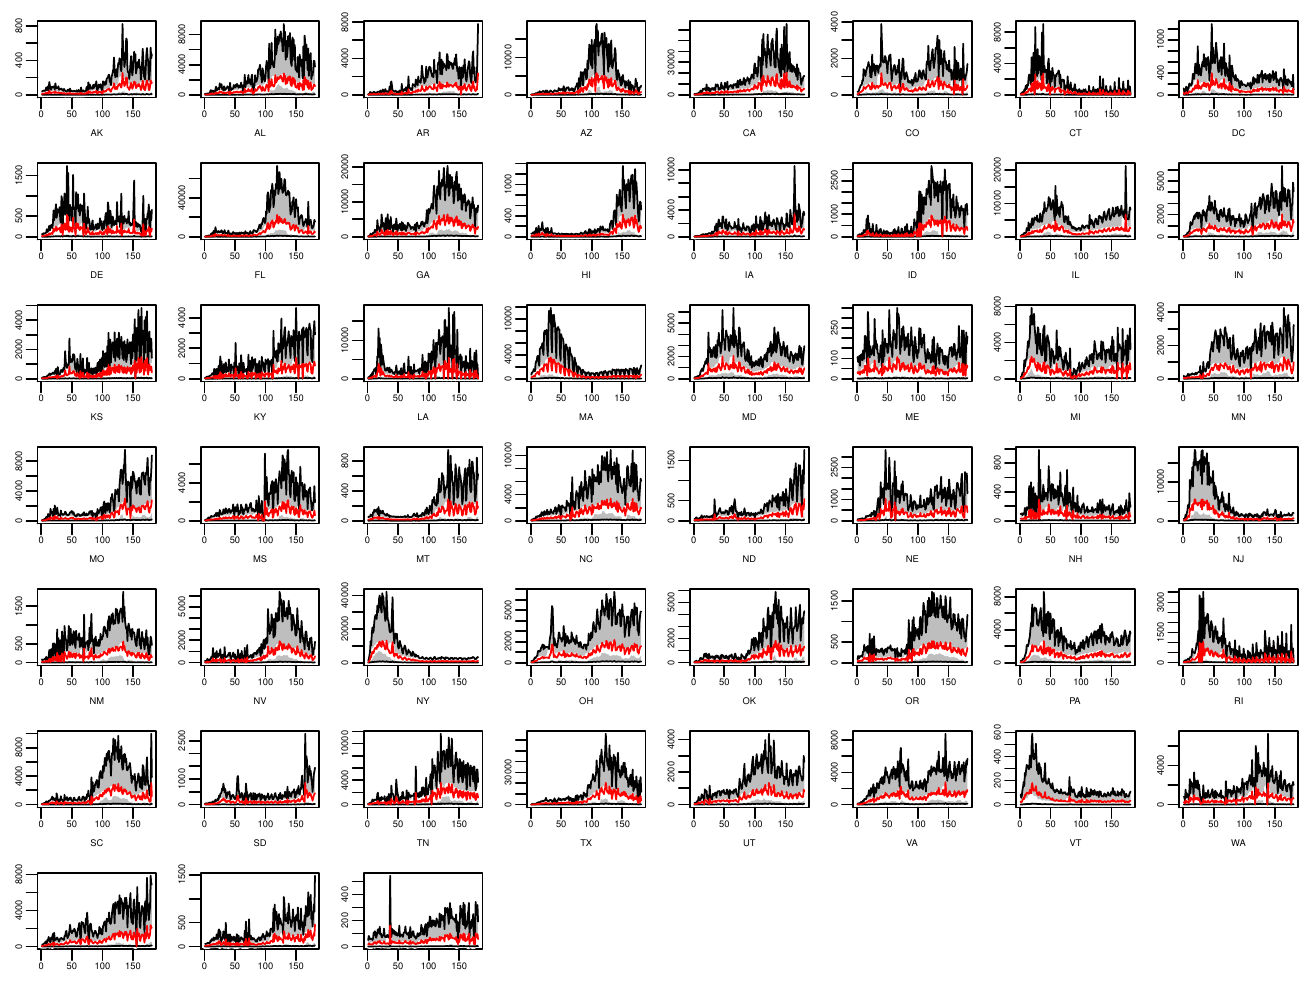
Figure 7. State-level estimated means of daily confirmed cases and related 90% confidence intervals. The gray band represents the 90% confidence interval, the white line the observations of the daily confirmed cases, and the red line the estimated mean